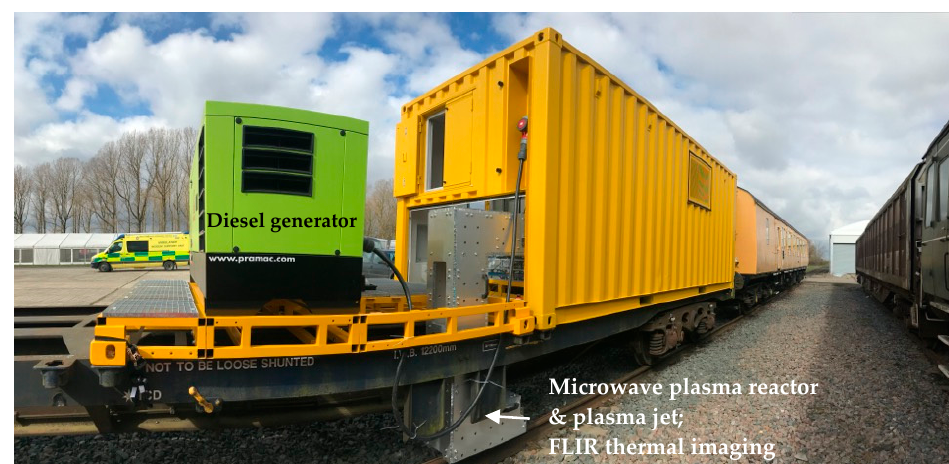
Figure 2. Photo of the mobile unit. Microwave generator, gas distribution and control systems mounted inside the yellow container. FLIR camera for thermal imaging mounted outside, targeting the contact between the plasma jet and the rail track. Videos of the laboratory and mobile on-track real condition testings have been uploaded in the supplementary files